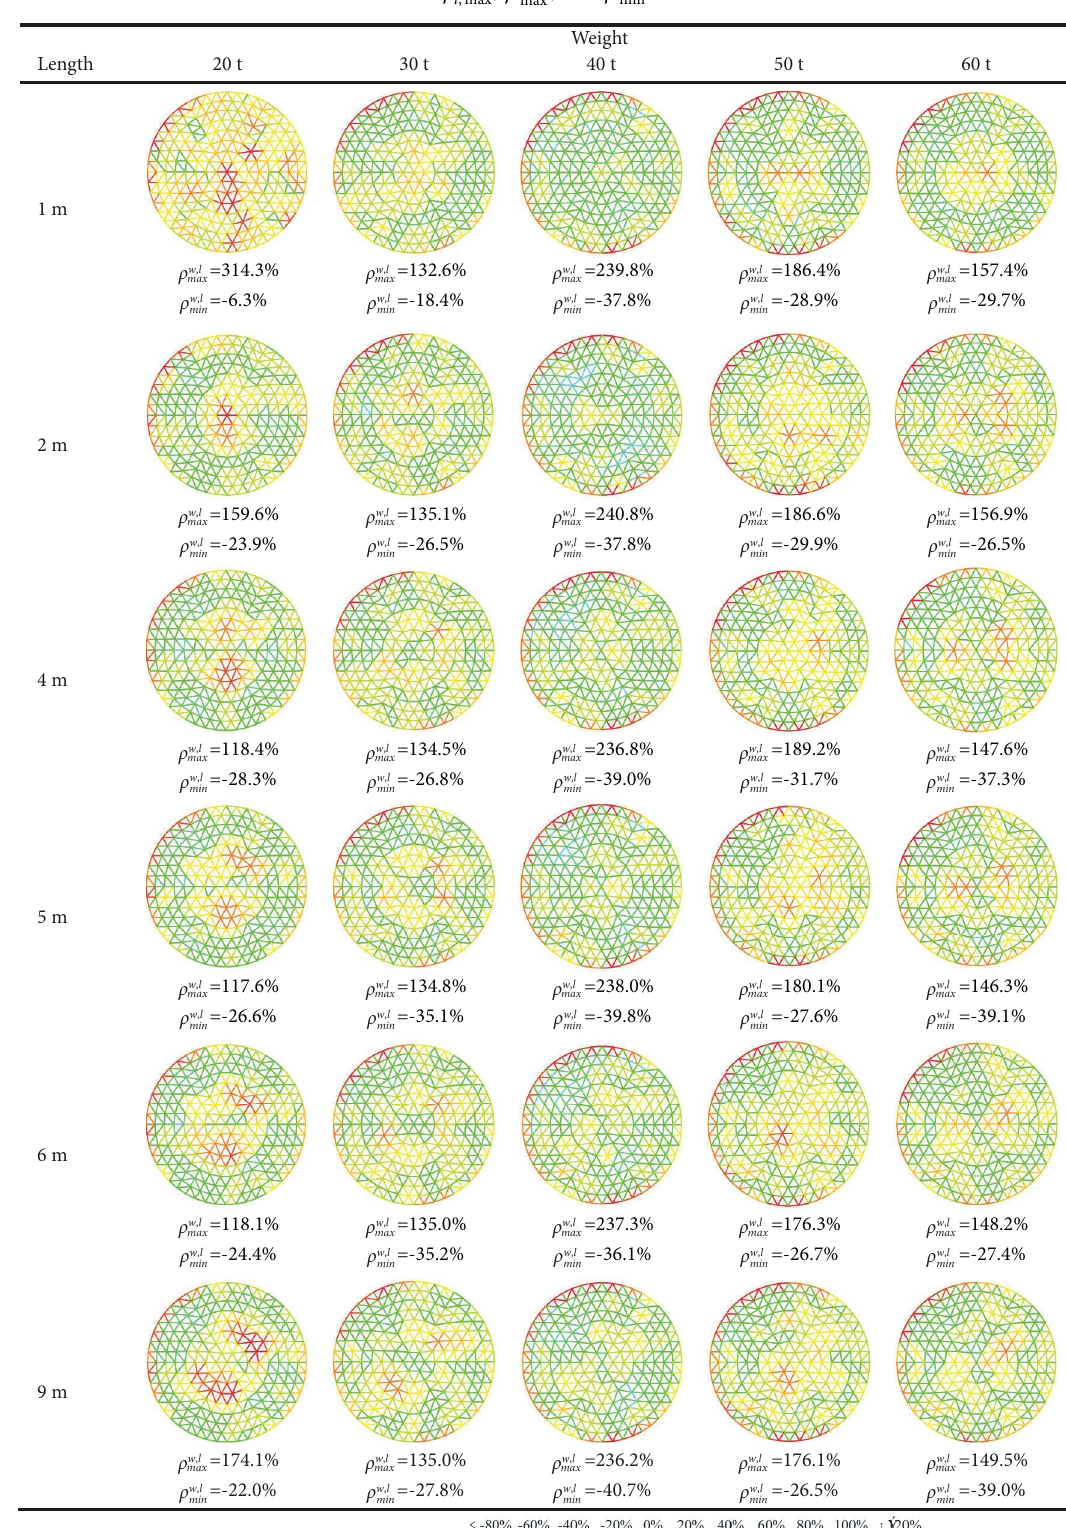
Table 5: Contours of the ρ w,l